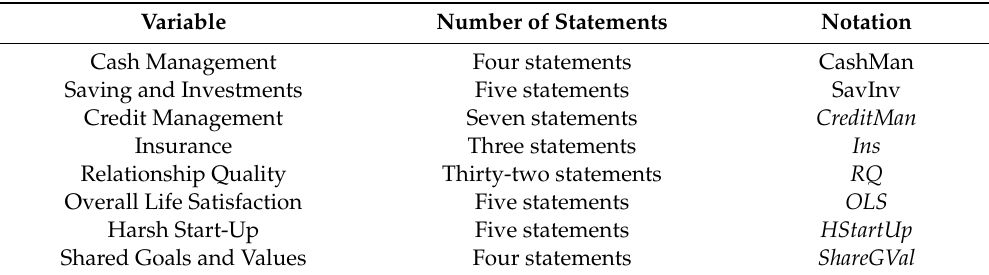
Table 1. Variables used in the study (designed by the authors).